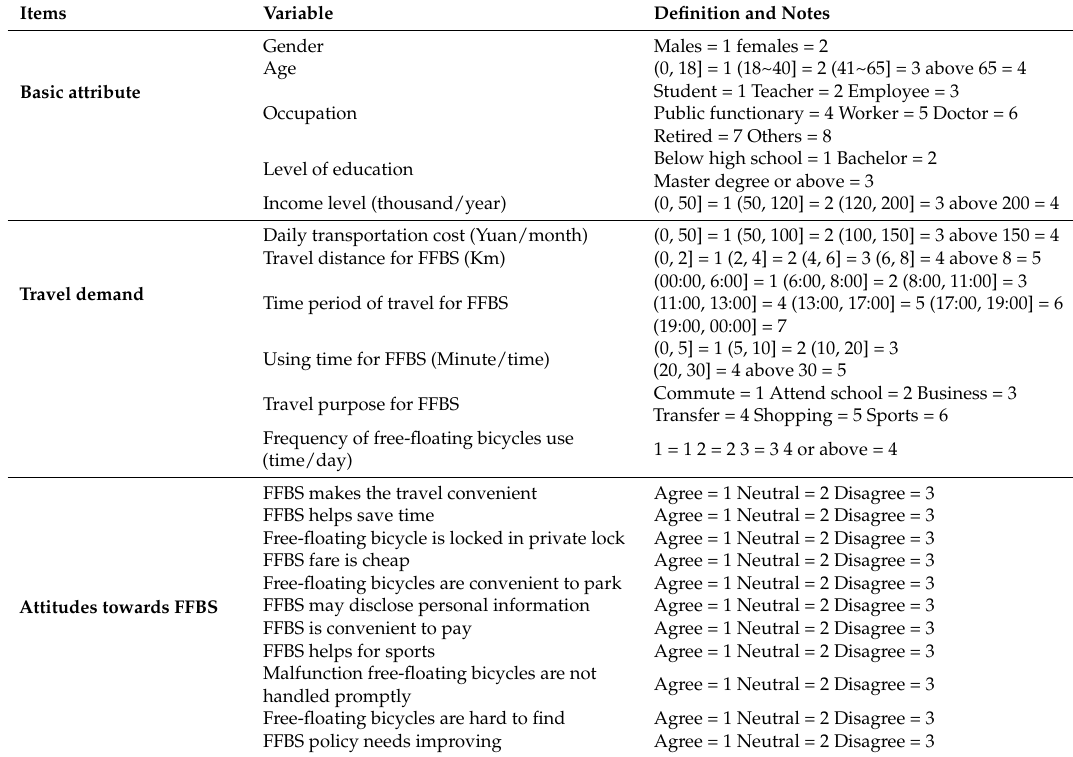
Table 2. The variables chosen to analyze the citizens’ preference on FFBS